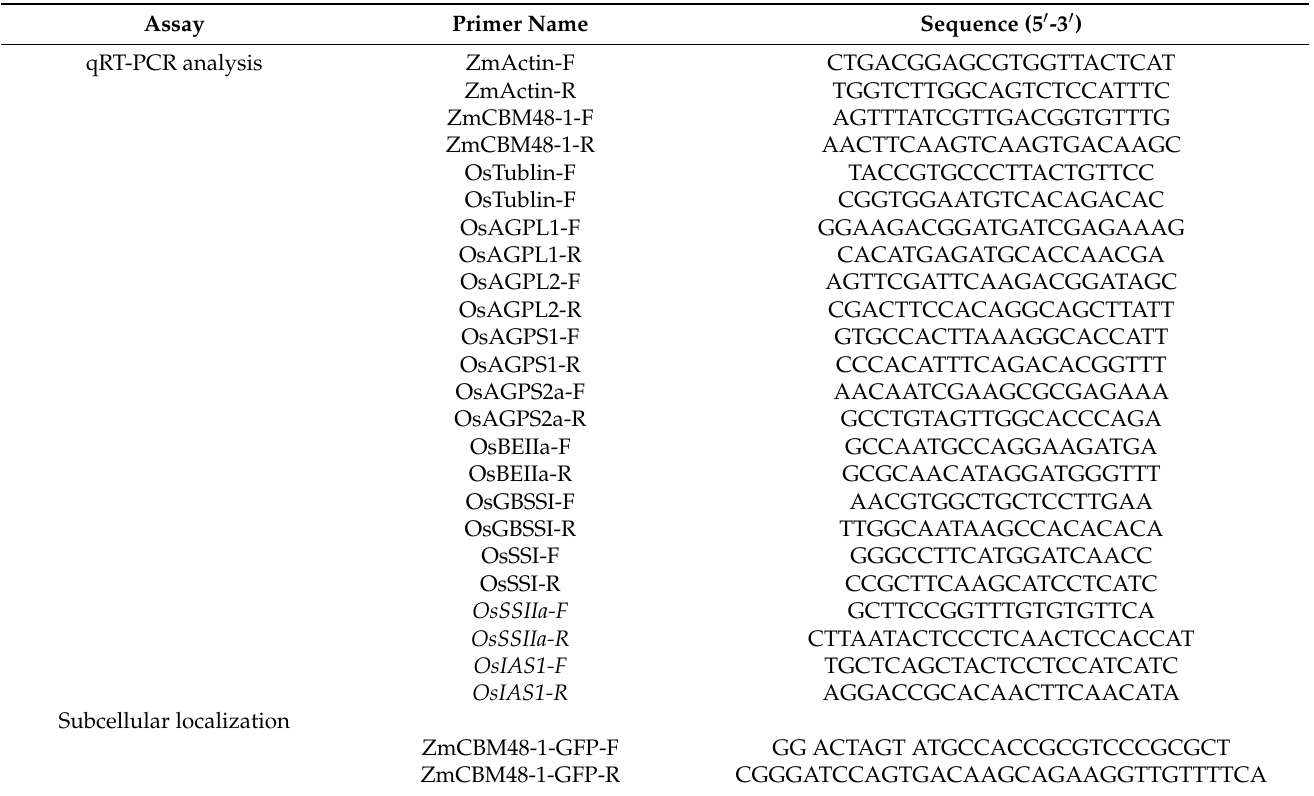
Table 1. Primers used in this